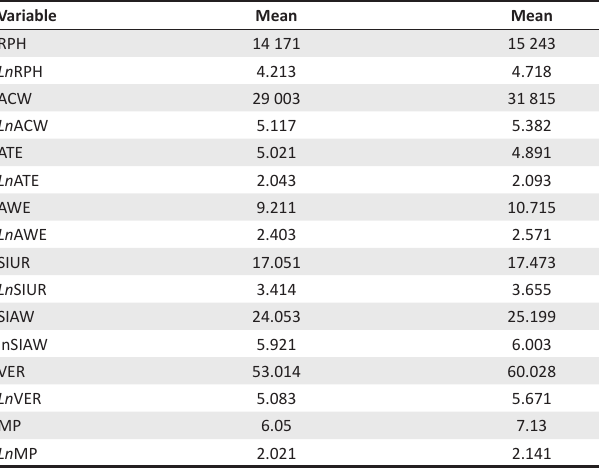
TABLE 1-A1: Major job code 71 Major job code